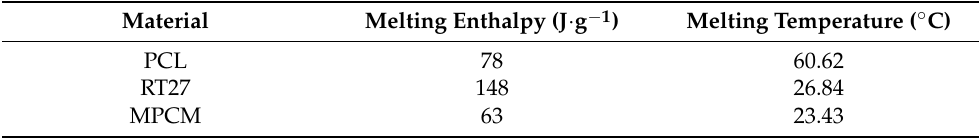
Table 1. Thermal properties of the raw materials.